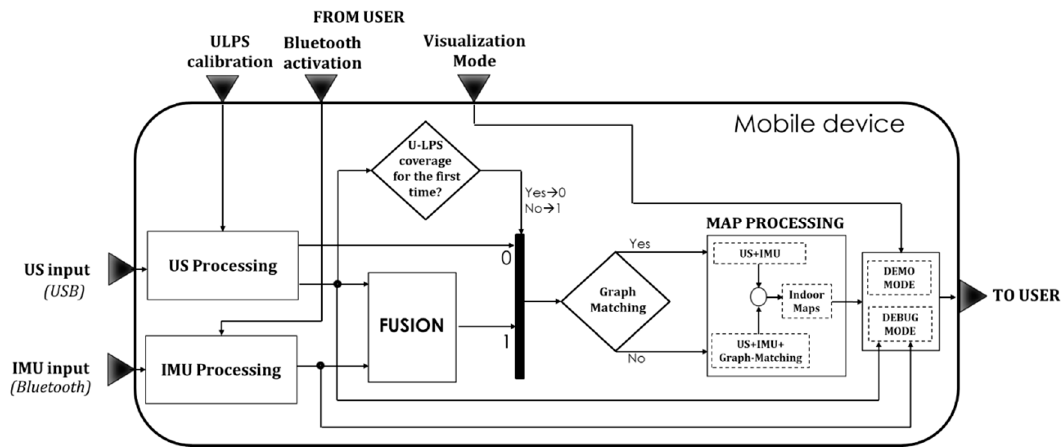
Sensors 2021 , 21 , x FOR PEER REVIEW Figure 6. Block diagram of the LOCATE-US application. Figure 6. Block diagram of the LOCATE-US application.